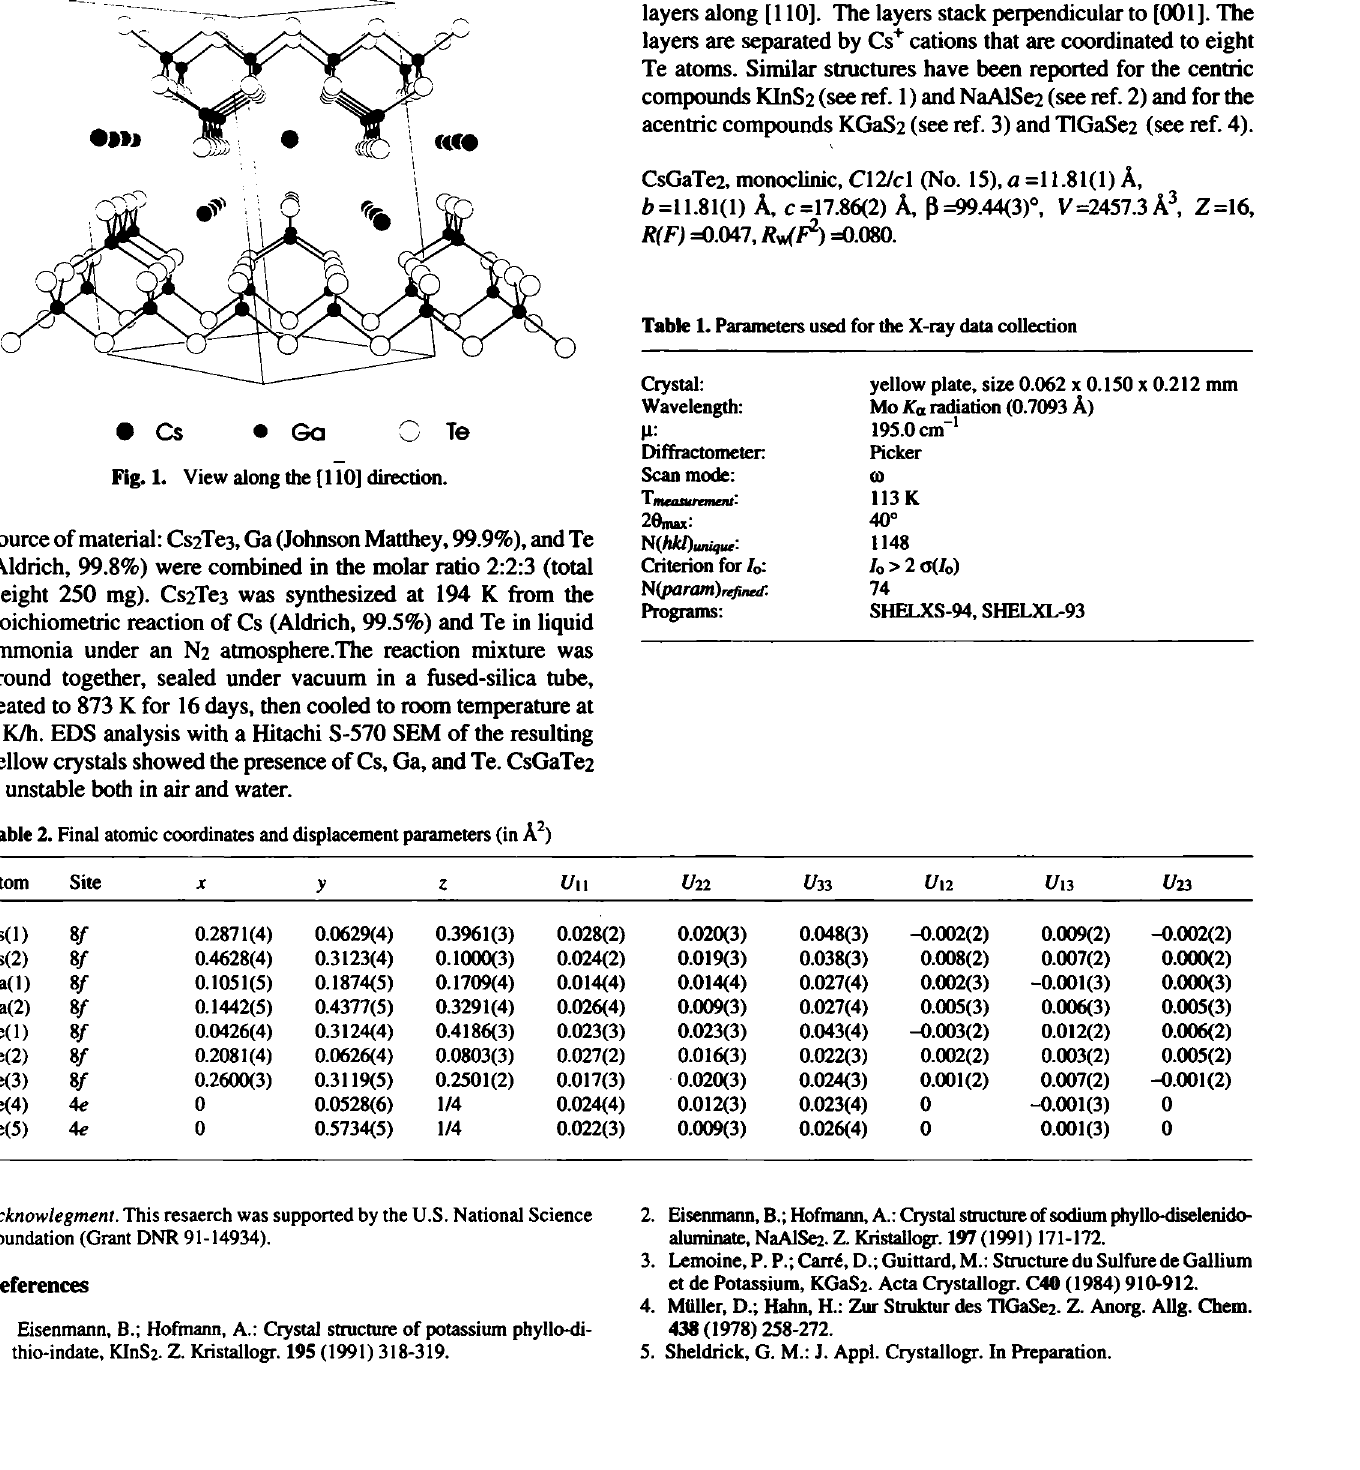
Table 1. Parameters used for the X-ray data collection